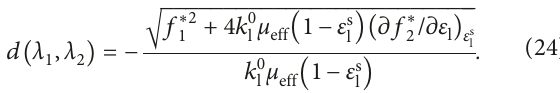
Figure 5: (a) Liquid saturation profile from time integration with periodic boundary conditions (same system as in Figure 2(b)). (b) Liquid velocity profile from time integration with periodic boundary conditions (same system as in Figure